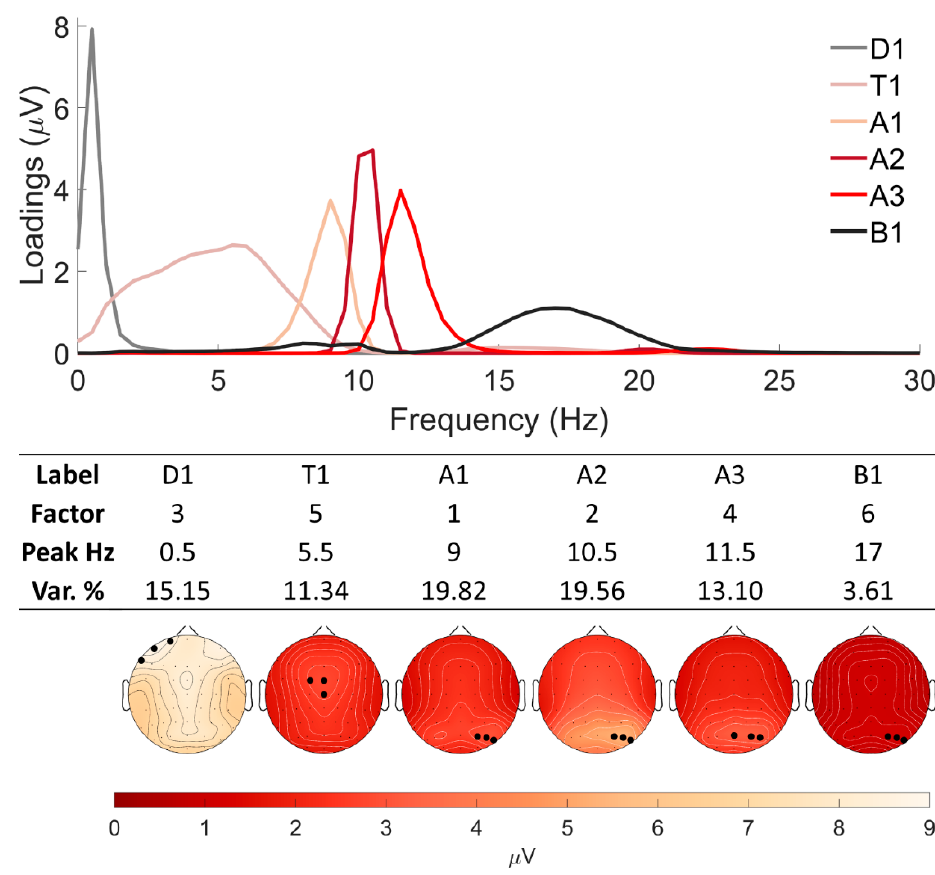
Figure 1. f-PCA outcomes for six factors. Top part: grand average loading scores of each factor. Middle part: individual labels, factor numbers, peak frequencies, and variance as percentage. Bottom part: grand average topographies of each component. Three electrodes with maximum values are marked with black dots.